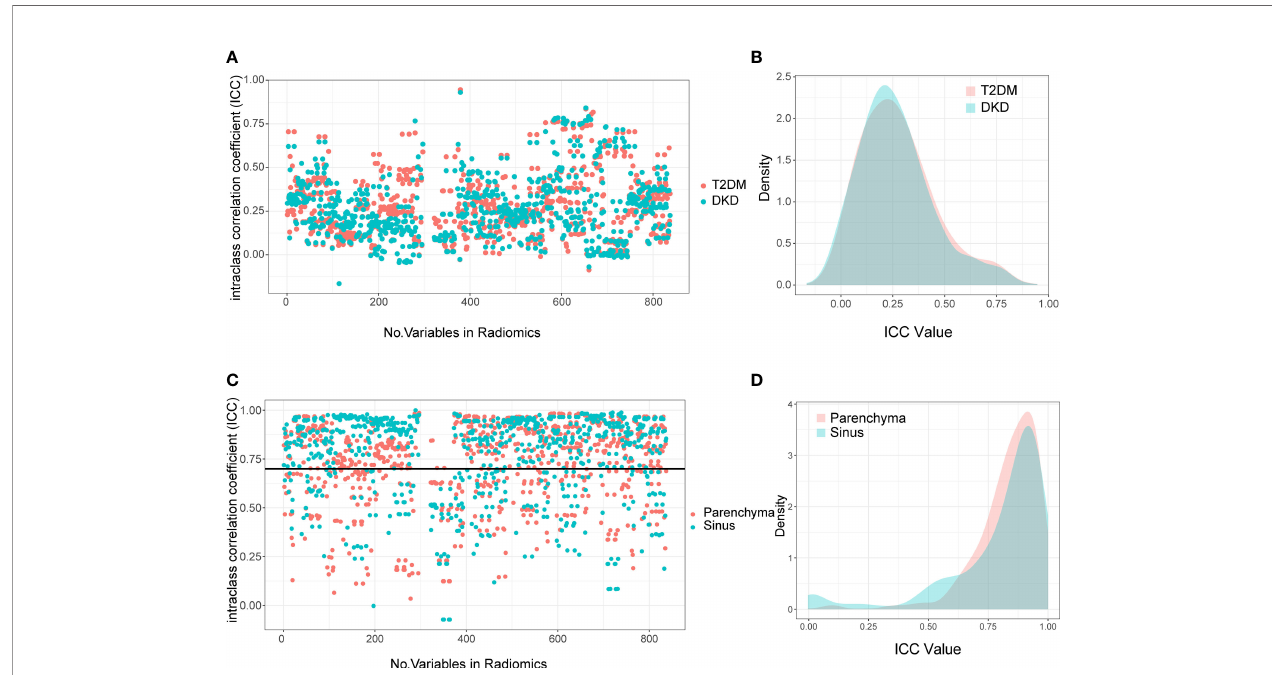
FIGURE 3 | Interclass Correlation Coef fi cients and Density Plots between Extracted Radiomics Variables. The Interclass Correlation Coef fi cients plot (A) and Density Plots (B) between parenchyma and sinus in T2DM and DKD group. The Interclass Correlation Coef fi cients plot (C) and Density Plots (D) between manual and automatic ROI drawing methods in T2DM and DKD group.